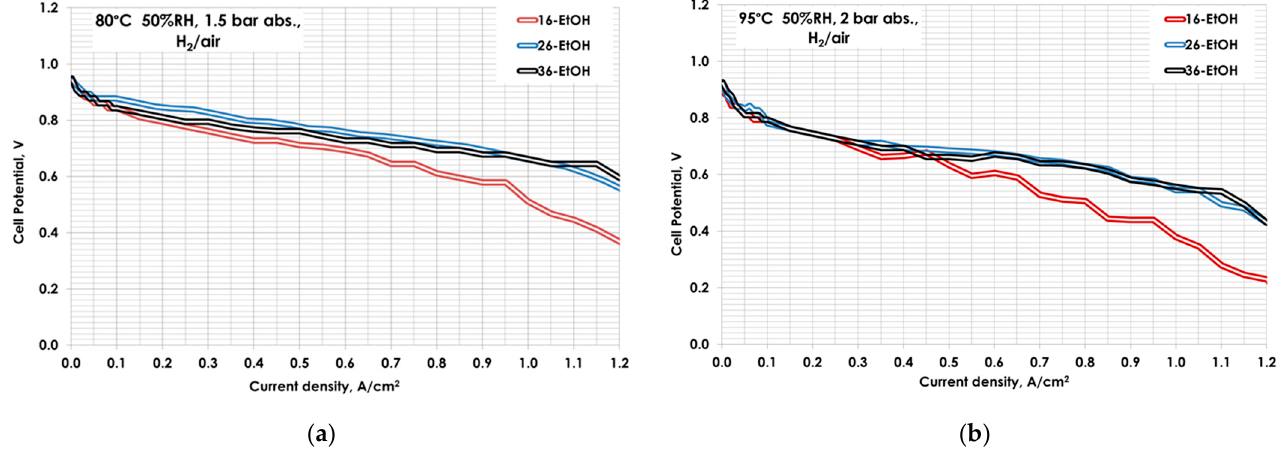
Figure 5. Polarization curves for 16- EtOH, 26-EtOH, and 36-EtOH at ( a ) 80 °C 50 RH% and 1.5 bar abs ( b ) 95 °C 50 RH% and 2 bar abs .